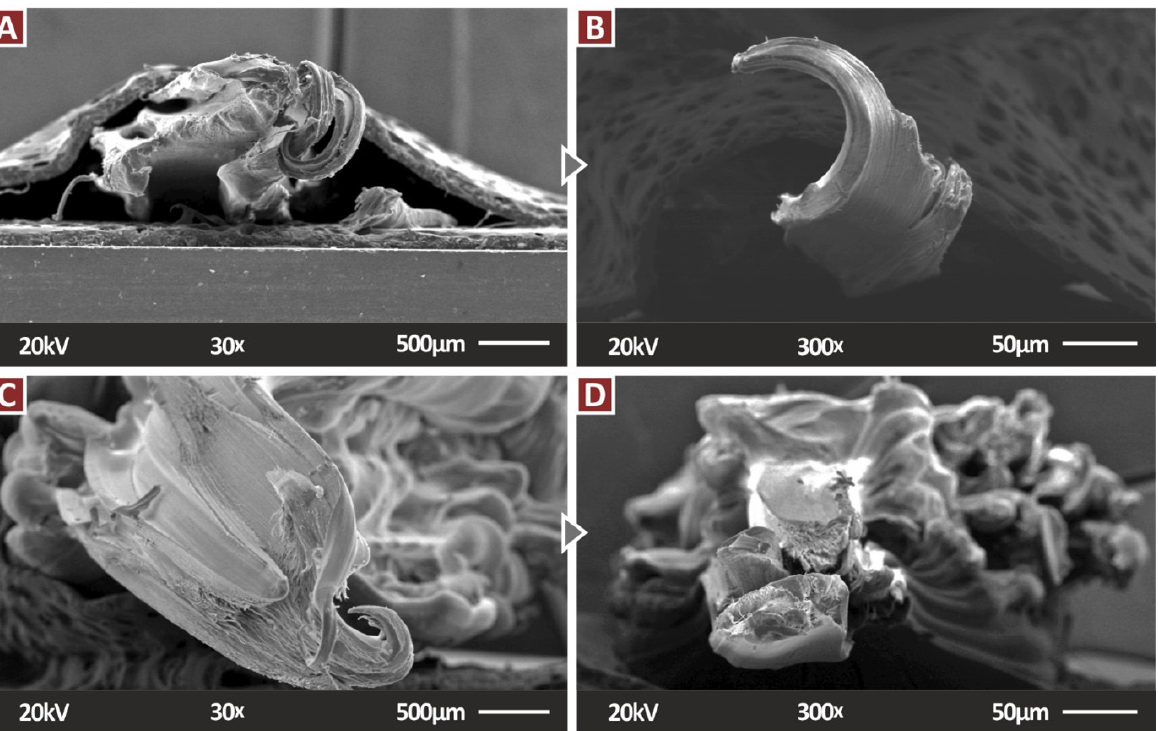
Figure 8. SEM images of the fracture area of 3D-printed HDPE/ZnO specimens at ( A ) 0.5 wt.%; ( B ) 2.5 wt.%; ( C ) 5 wt.%; and ( D ) 10 wt.%. Keep in mind that randomly selected tensile specimens from each material are